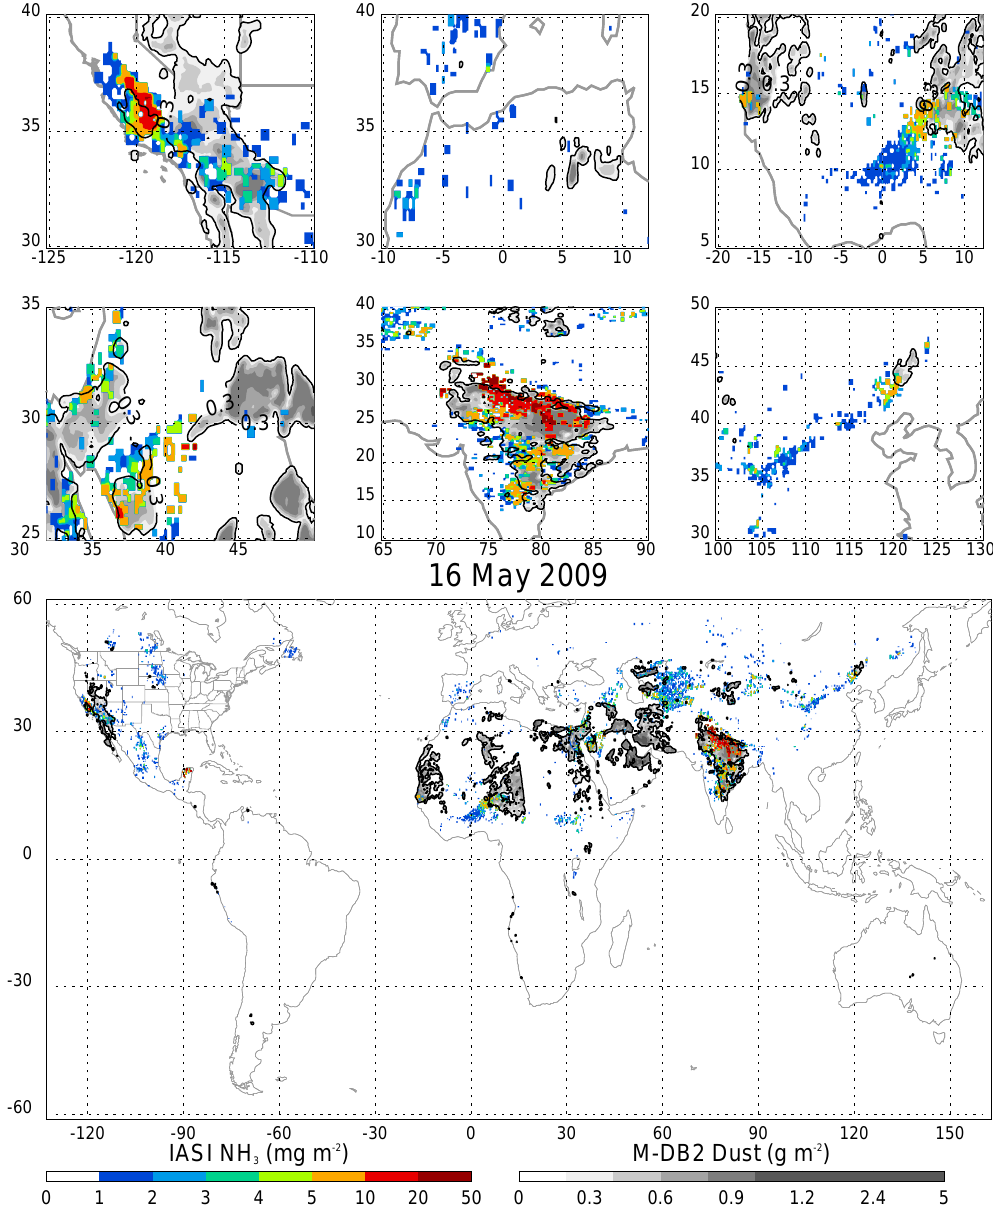
Fig. 1. Global (lower panel) distribution of M-DB2 dust column burden (gm − 2 ; grey shading) and IASI NH 3 column burden (mgm − 2 ; color shading), on 16 May 2009. The upper panels provide a zoom over 6